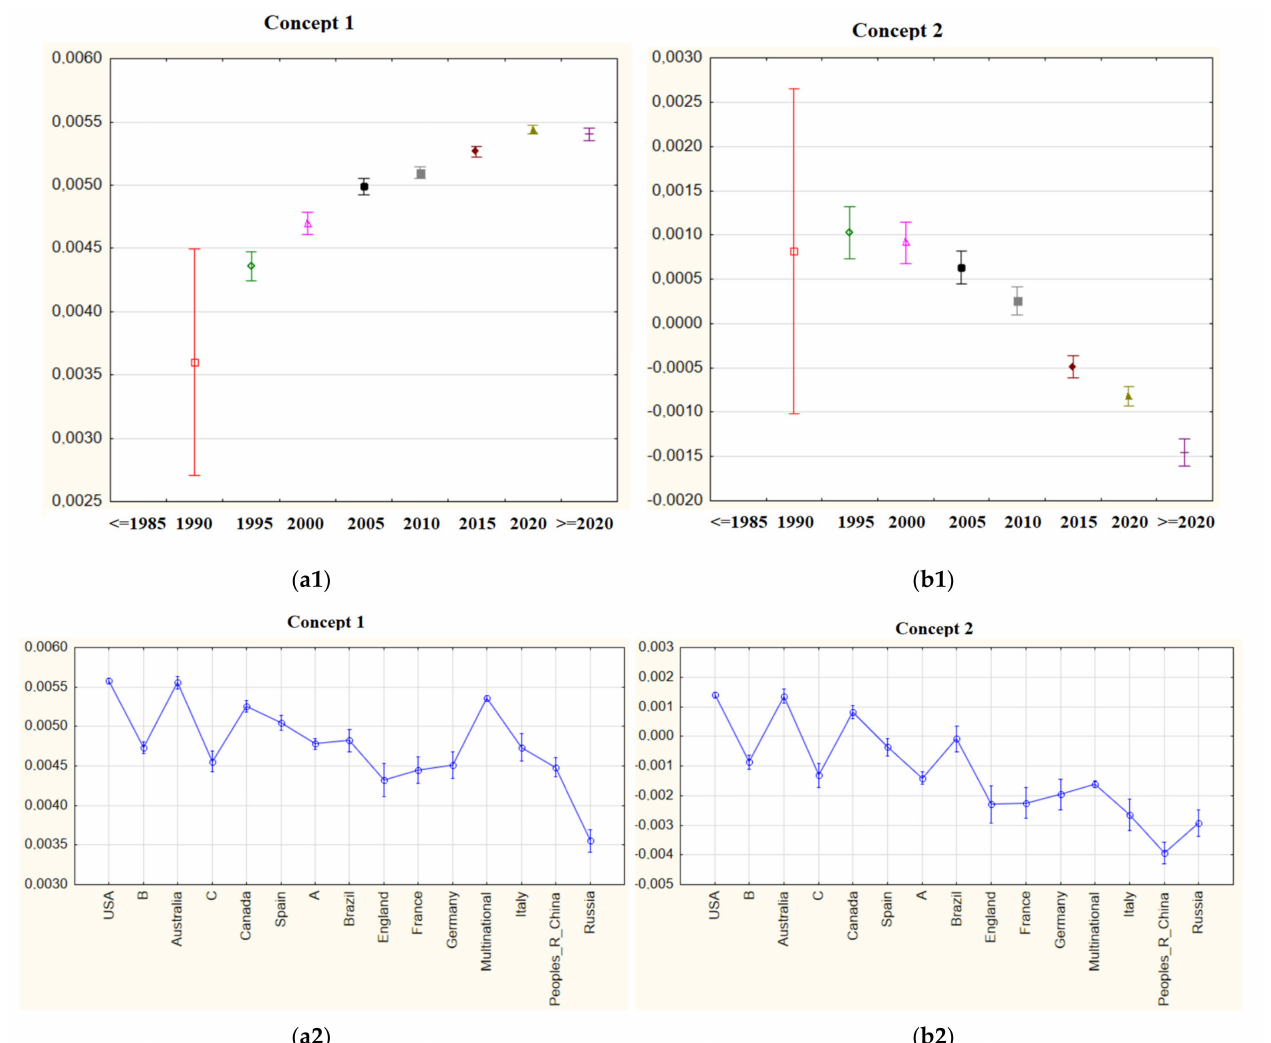
Figure 15. ( a1 ) mean importance weights of Concept 1 for five-year periods; ( b1 ) mean importance weights of Concept 2 for five-year periods; ( a2 ) mean importance weights of Concept 1 via countries; ( b2 ) mean importance weights of Concept 2 via